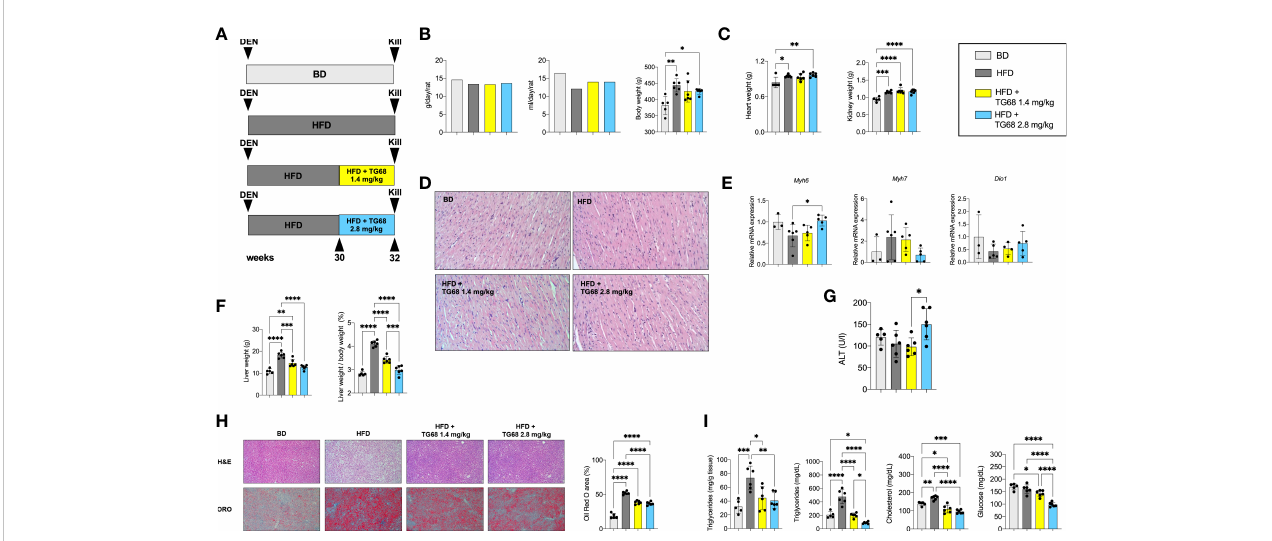
FIGURE 4 TG68 effectively reduces fat accumulation in the absence of signi fi cant cardiotoxic effects. (A) Experimental design and timeline of the in vivo experiments; (B) Daily food intake, water consumption and body weight of rats fed basal diet (BD), HFD alone or co-treated with 1.4 or 2.8 mg/kg of TG68; (C) Heart and kidney weight of rats treated as in A; (D) H&E staining of heart sections from rats treated as in A (H&E 20x); (E) qRT-PCR analysis of Myh6 , Myh7 and Dio1 mRNA in the heart of rats treated as in A; (F) Liver weight and liver weight/body weight ratio; (G) Serum ALT levels; (H) Representative images of liver sections stained with hematoxylin and eosin (H&E, 10x) or Oil Red O (ORO 10x) at 1.4 or 2.8 mg/kg of TG68, and quanti fi cation of ORO staining positive area by using ImageJ; (I) Hepatic content of triglycerides and serum levels of triglycerides, cholesterol and glucose. Gene expression is reported as fold-change relative to livers from rats fed a basal diet. The bar graphs represent mean value + SD of 3 to 6 rats/ group. Groups were compared by using one-way ANOVA followed by Tukey post hoc analysis. * p <0.05 , **p< 0.01 , ***p <0.001 ,****p <0.0001. BD, basal diet; DEN, Diethylnitrosamine; HFD, high fat diet.